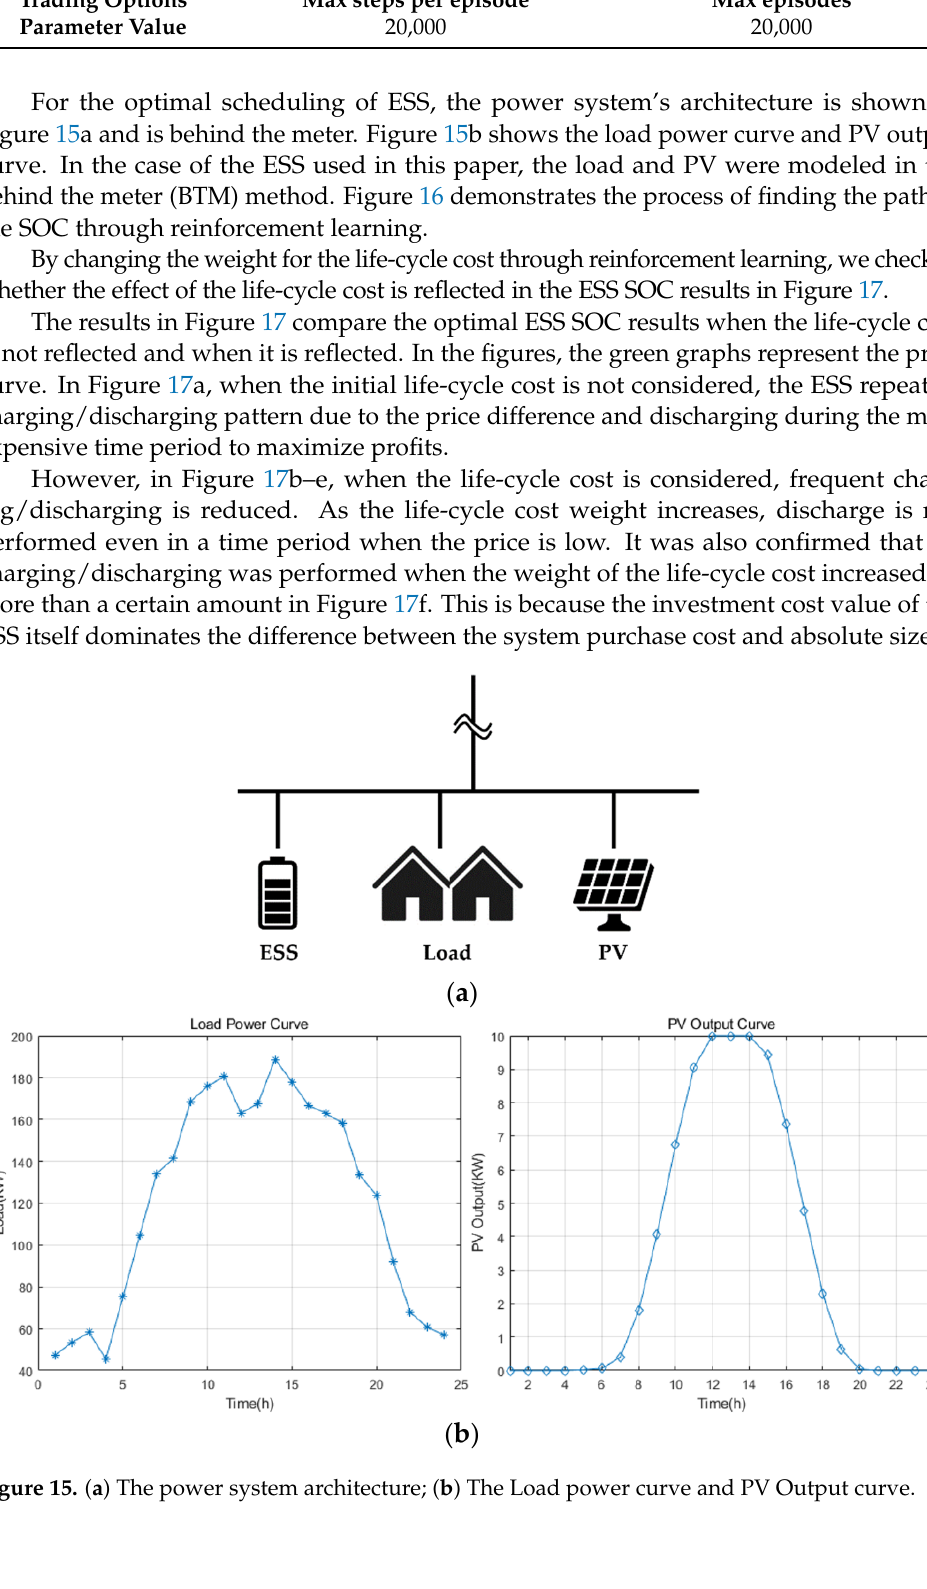
Figure 16. An example of solving an ESS optimization problem through Q-learning.